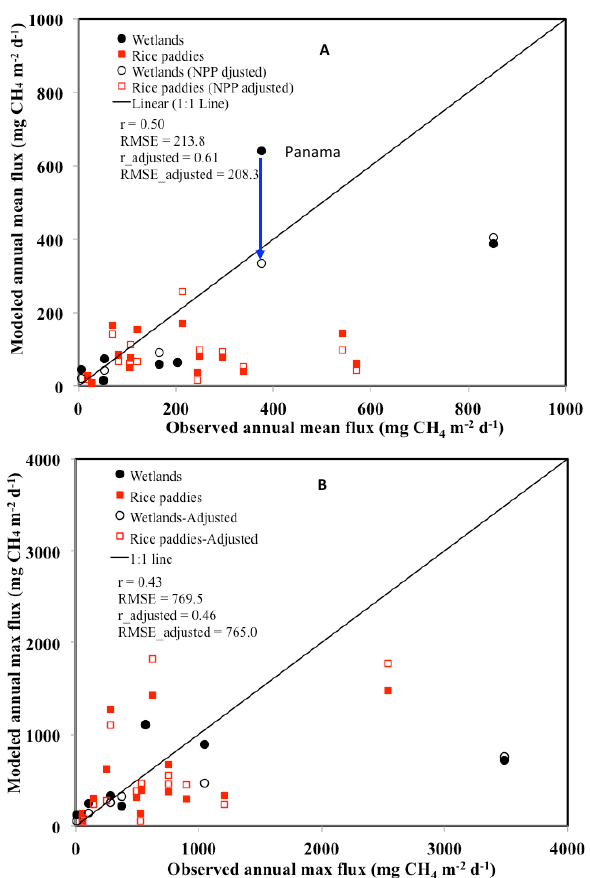
Fig. 11. Scatter plot of observed and model (and NPP adjusted) simulated annual mean (top) and annual maximum of the daily averaged (bottom) methane emissions (mg CH 4 m -2 d -1 ) at the rice paddies and wetlands.